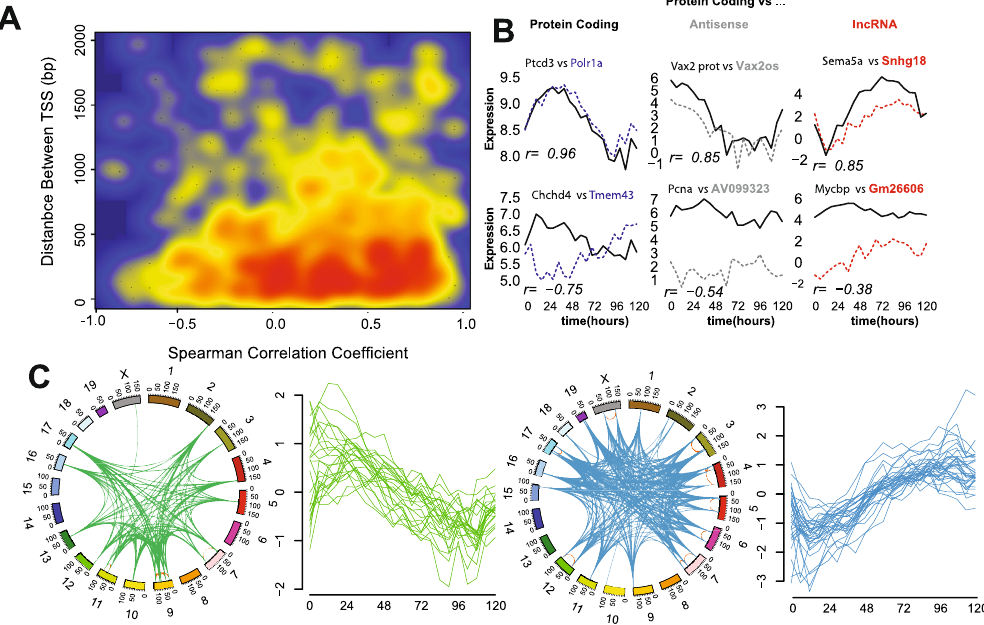
Figure 3. Analysis of gene co-expression patterns using augmented temporal resolution. ( A ) Smoothed scatter plot showing the correlation coefficient across the time course vs. distance between transcriptional start sites (TSS) of bidirectional gene pairs. Blue indicates no gene pairs; yellow and red indicate increasing numbers of pairs sharing similar properties. ( B ) Expression patterns of example bidirectional genes of the same or different gene biotype. Spearman’s correlation coefficient is reported for each pair. ( C ) Genomic location (circos) and expression pattern (line plot) of two independent co-expressed groups of 5 or more contiguous genes sharing correlated expression (r >